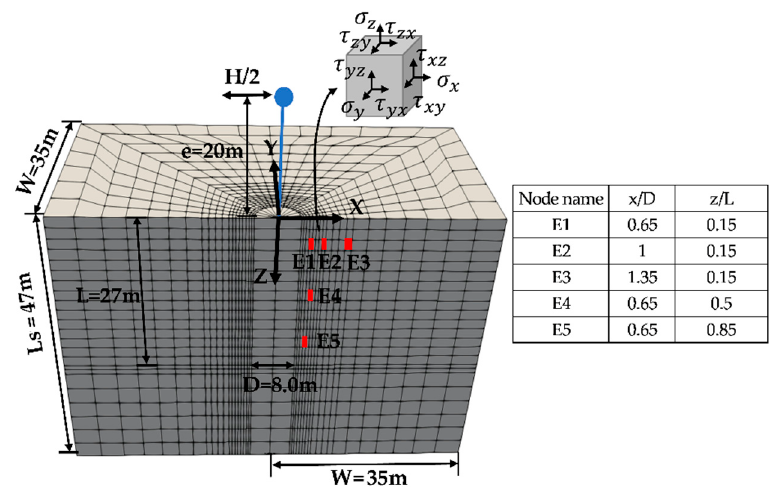
Figure 1. Finite element model for monopile and investigated soil elements.